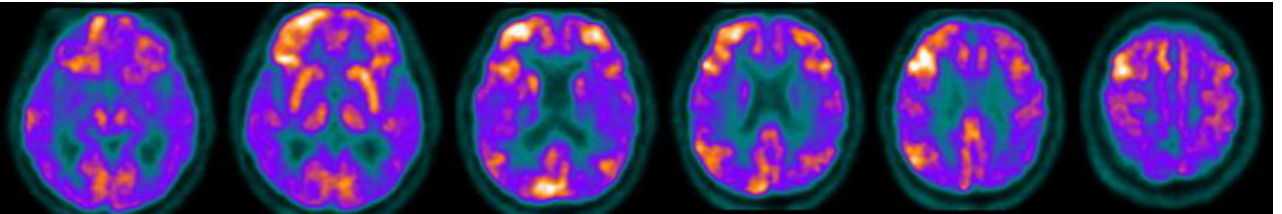
Figure 1. FDG-PET after the first neurological